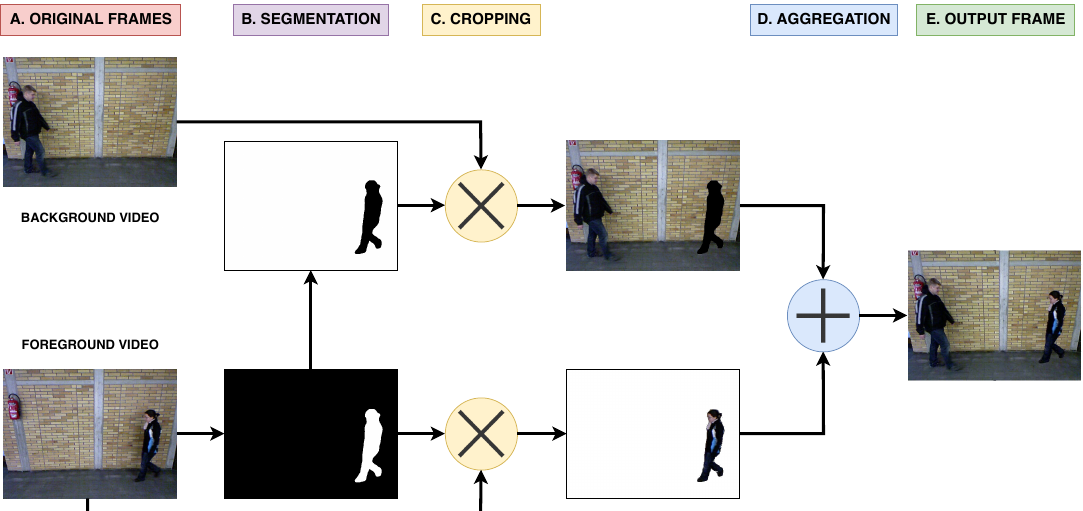
Figure 1. Multiple Person Gait framework (MuPeG) framework. ( A ) The inputs are two frames belonging to videos of different subjects. ( B ) Binary mask of the lower frame is obtained by segmentation. At the same time, the negative mask is computed for the upper frame. ( C ) Cropping operation is computed as the element-wise product of the masks by the corresponding frames. ( D ) Both frames are aggregated with an element-wise add operation. ( E ) The final output contains both